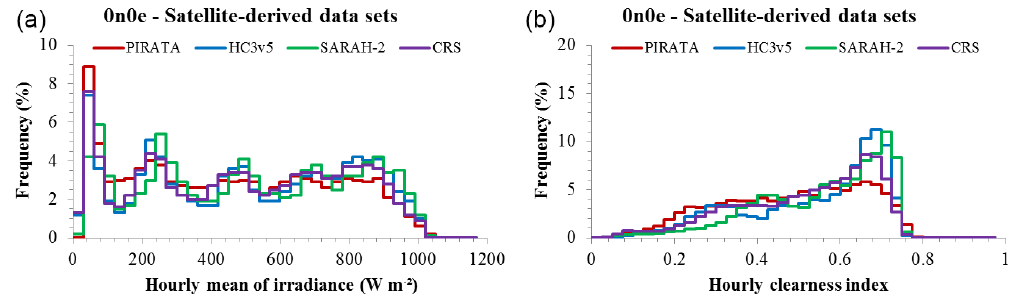
Figure A2. Frequency distributions of PIRATA measurements (red) and data sets (HC3v5: blue, SARAH-2: green, CRS: purple) at 0 ◦ N, 0 ◦ E for E (a) and KT (b) . If the coloured line is above (below) the red one for a given sub-range of values, it means that the data set produces these values too frequently (too rarely) with respect to the PIRATA measurements.